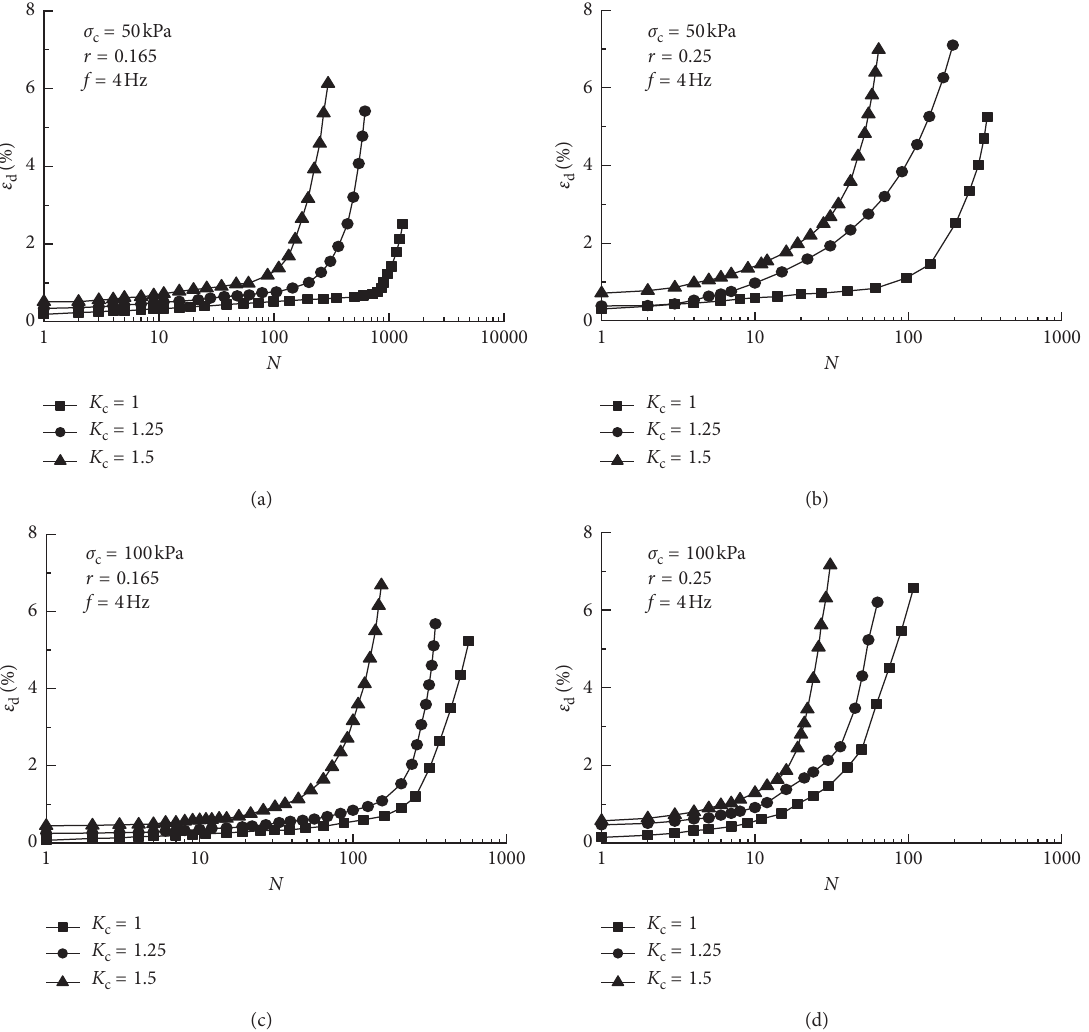
Figure 8: Relationship curves between ε (c) σ c � 100kPa, r � 0.165. (d) σ c � 100kPa, r �